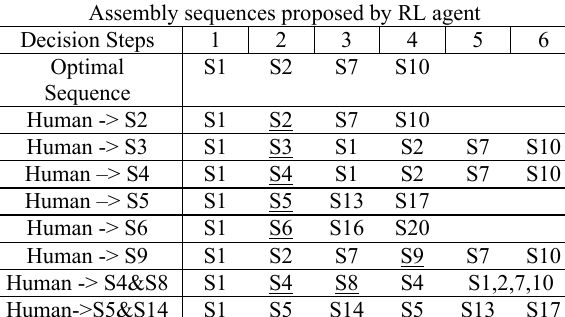
Table 2. Assembly sequences described by the list of states, corresponding to assembly tasks. Every row in the table corresponds to the activation of a non-expected task (the modified states in underlined bold) Assembly sequences proposed by RL